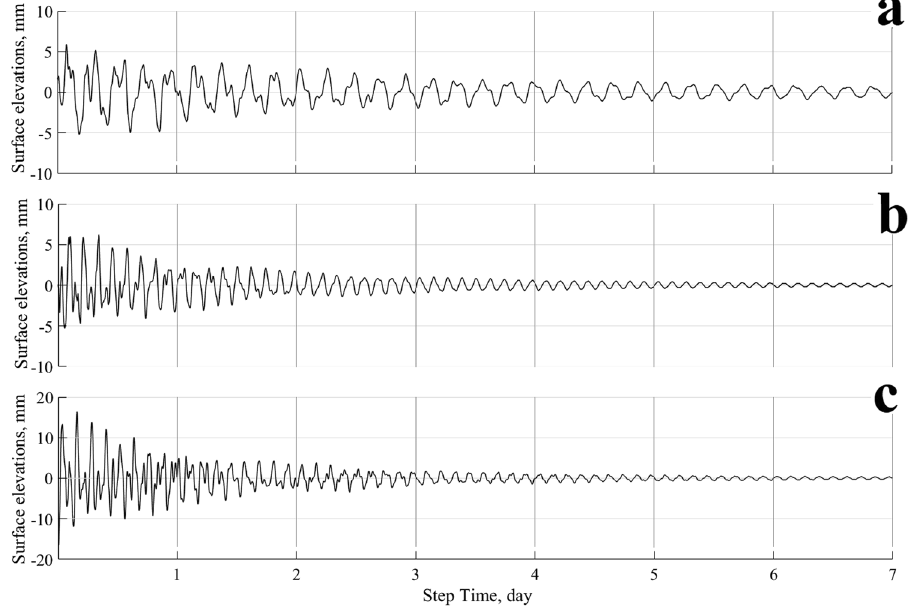
Figure 4. Modelling of surface water elevations at the measurement sites ( a ) northeast, ( b ) east, and ( c ) west.